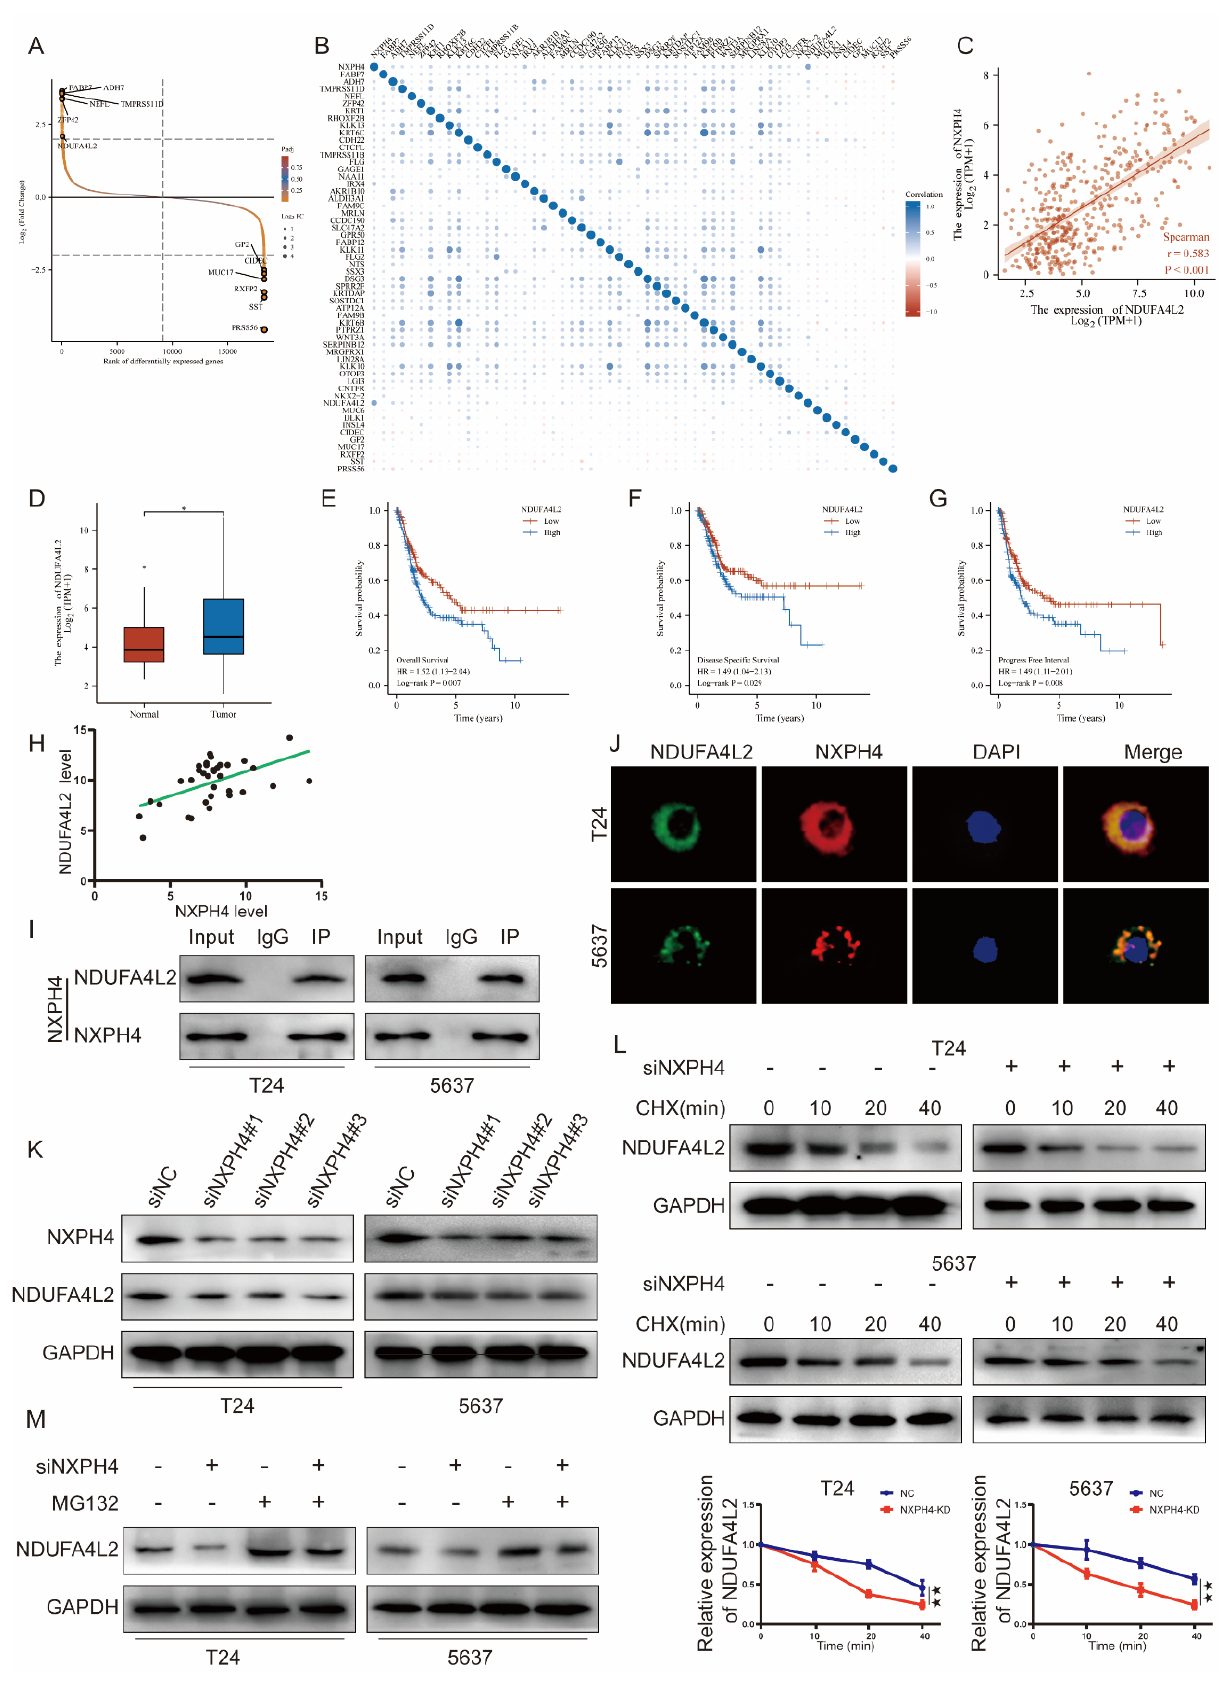
Figure 7. NDUFA4L2 is a downstream of NXPH4 in bladder cancer. ( A ) The top